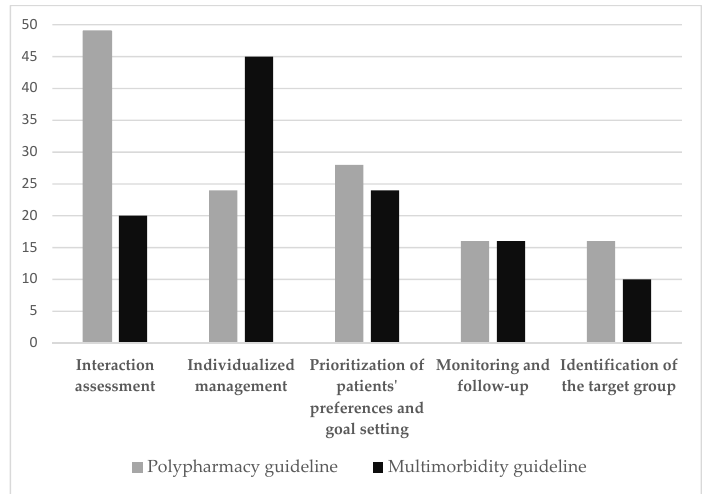
Figure 1. Distribution of recommendations.